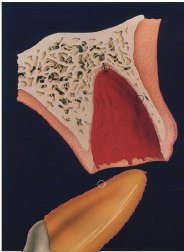
Figure 1. Avulsion of the tooth